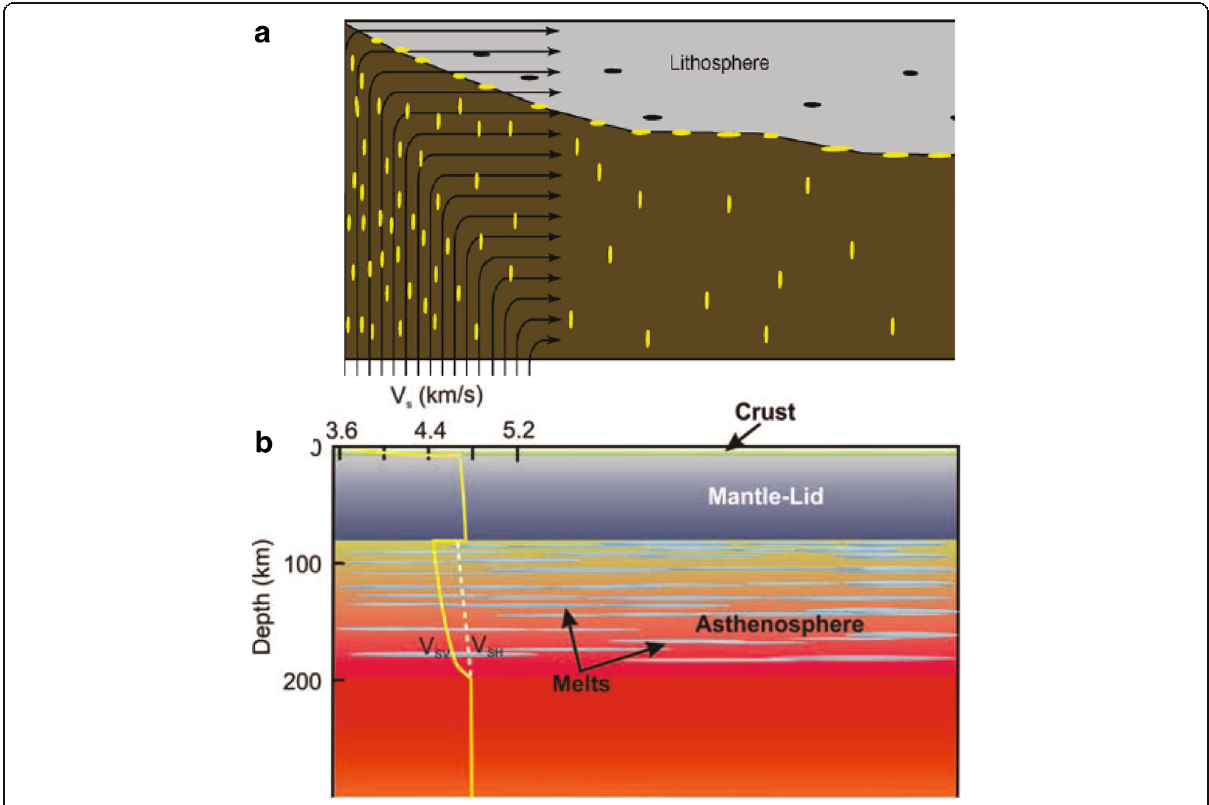
Fig. 12 Two possible models that might explain geophysical anomalies (low seismic wave velocities and high electrical conductivity) by partial melting. a Accumulation of melt at the lithosphere-asthenosphere boundary (after Hirschmann 2010). b Presence of melt-rich layers (after Kawakatsu et al.